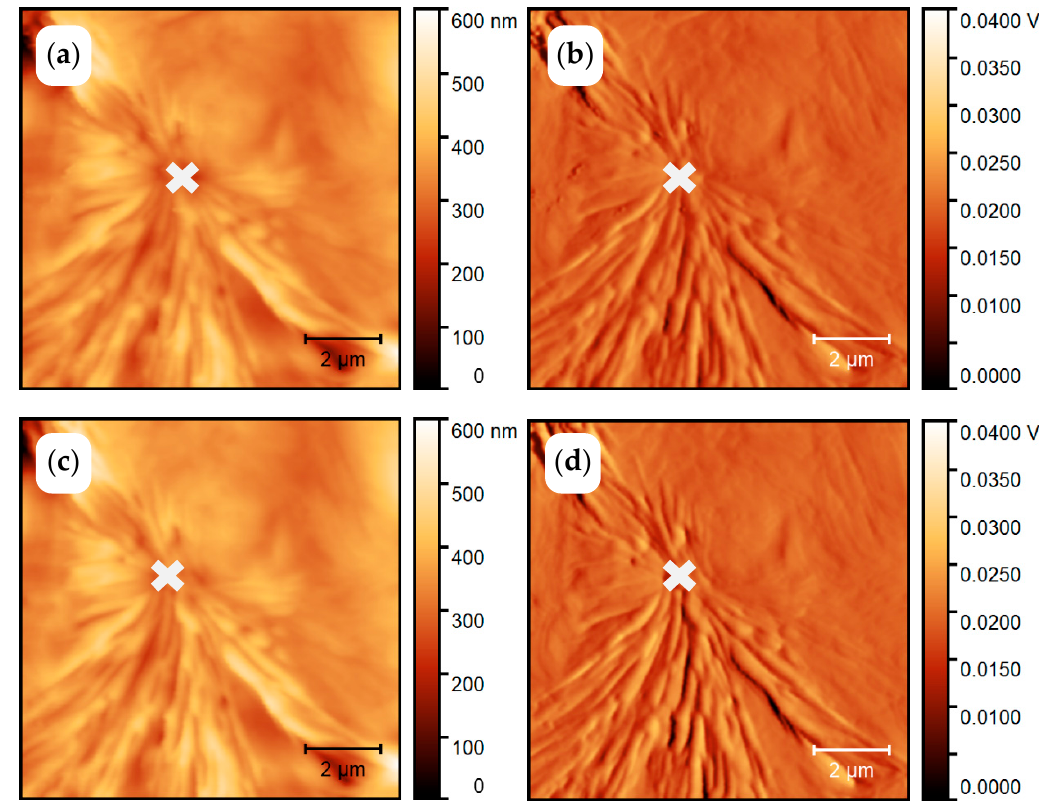
Figure 5. AFM images of poly( ε -caprolactone) (PCL) annealed at 325 K. The left column shows the topology and the right column shows the amplitude images. Images ( a , b ) are collected between 1000 and 3000 s and images ( c , d ) between 3000 and 5000 s after the quench.